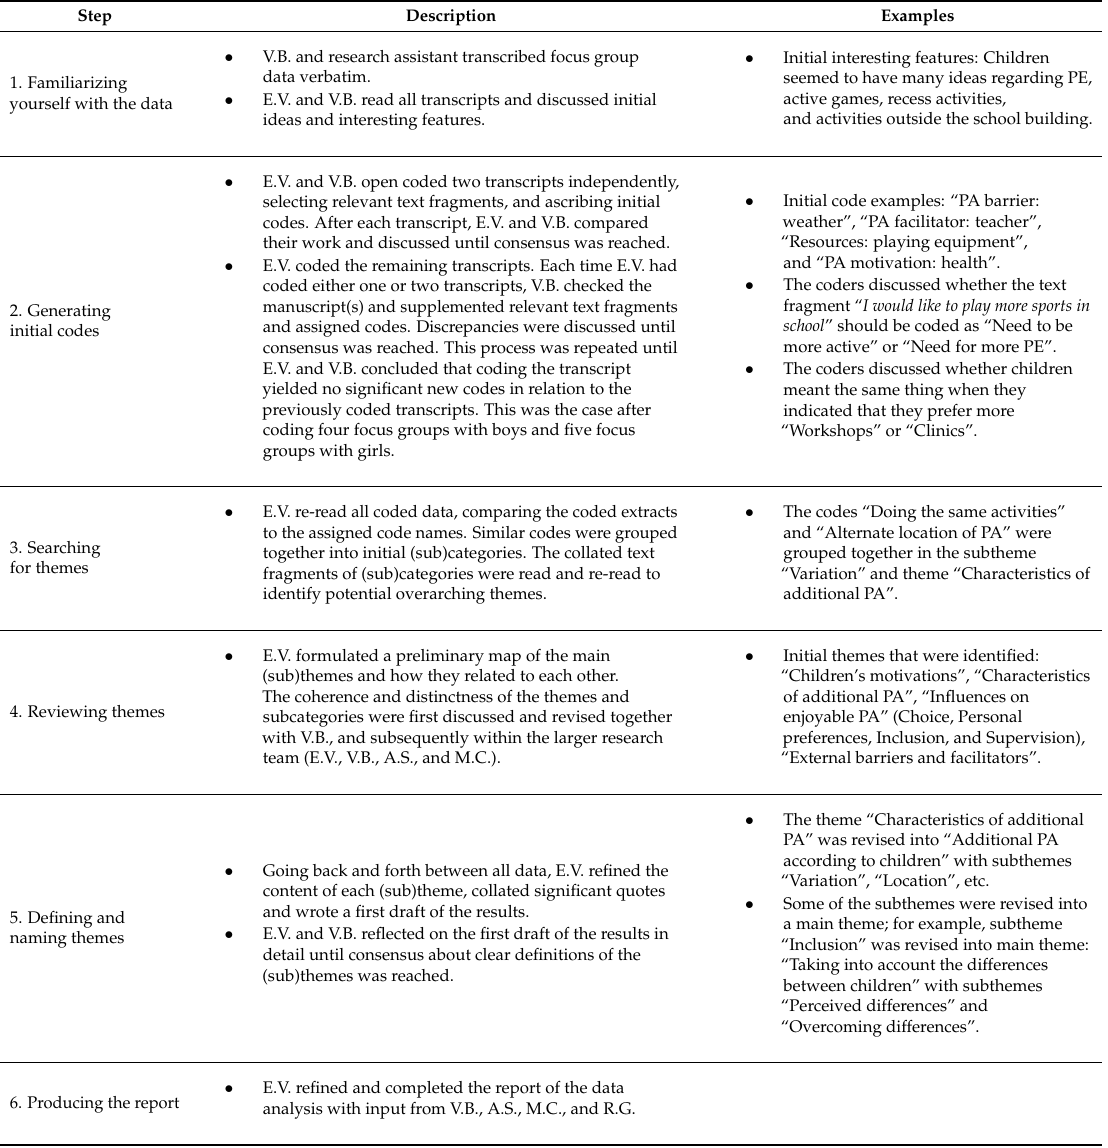
Table 2. Audit trail of the data analysis, following the steps of Braun and Clarke